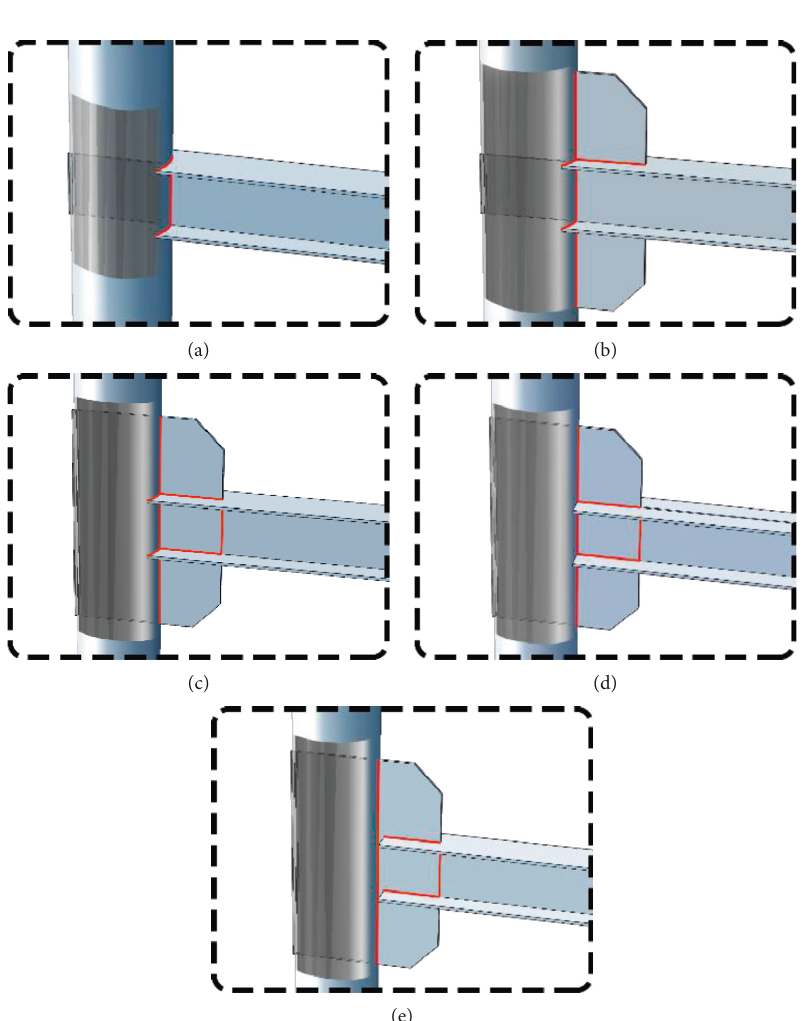
Figure 1: Graphicmodels of thefive specimens.(a)Specimen SP-1.(b) SpecimenSP-2. (c)Specimen SP-3.(d) SpecimenSP-4.